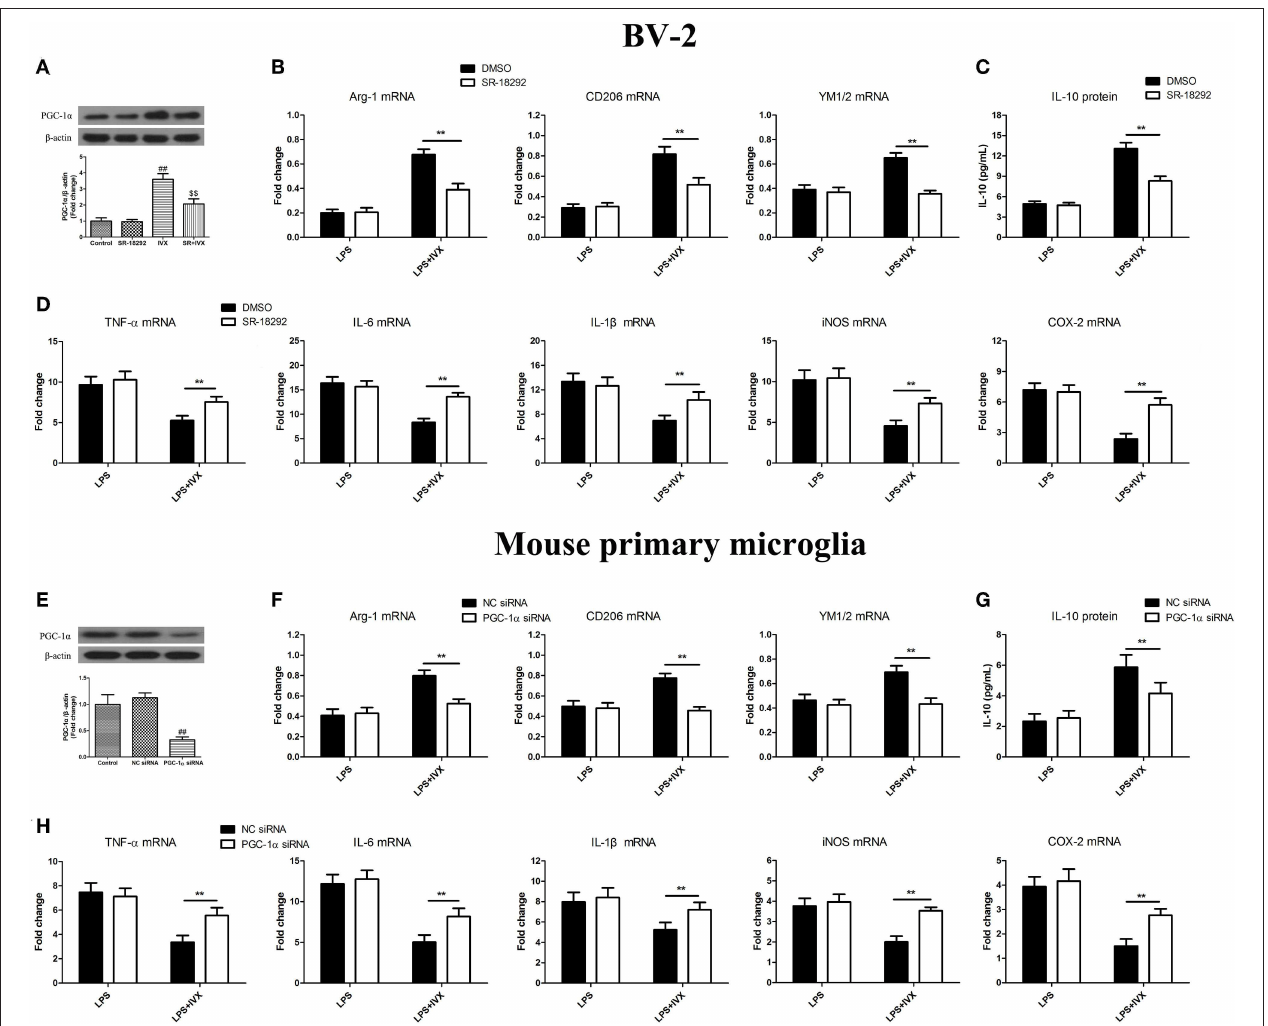
FIGURE 4 | PGC-1 α activation is involved in IVX-mediated microglial polarization in LPS- induced BV-2 cells and mouse primary microglia. (A) After treatment with SR-18292 (an inhibitor of PGC-1 α ) for 3h and PGC-1 α siRNA for 24h and then IVX for 2h in BV-2 cells and mouse primary microglia, the protein expression of PGC-1 α was measured with Western blotting. Following pretreatment with 2.5 µ M SR-18292 for 3h and PGC-1 α siRNA for 24h, cells were treated with IVX (200 µ g/mL) for 2h and then stimulated with LPS (100ng/mL) for 6h. (E) The protein expression of PGC-1 α was detected via Western blotting. (B,F) The mRNA expression of M2 microglial markers (Arg-1, CD206, and YM1/2) were detected via RT-PCR. (D,H) The mRNA expression of M1 microglial markers (TNF- α , IL-6, IL-1 β , iNOS, and COX-2) were detected via RT-PCR. Pretreatment with 2.5 µ M SR-18292 for 3h and PGC-1 α siRNA for 24h, cells were treated with IVX (200 µ g/mL) for 2h and then stimulated with LPS (100ng/mL) for 24h. (C,G) The release of IL-10 was measured with ELISA. The experiments were conducted in triplicate and repeated at least three times. Values are expressed as mean ± SEM ( n = 4 in each group). ## p < 0.01, vs. control group; $$ p < 0.01, vs. IVX group; ** p <